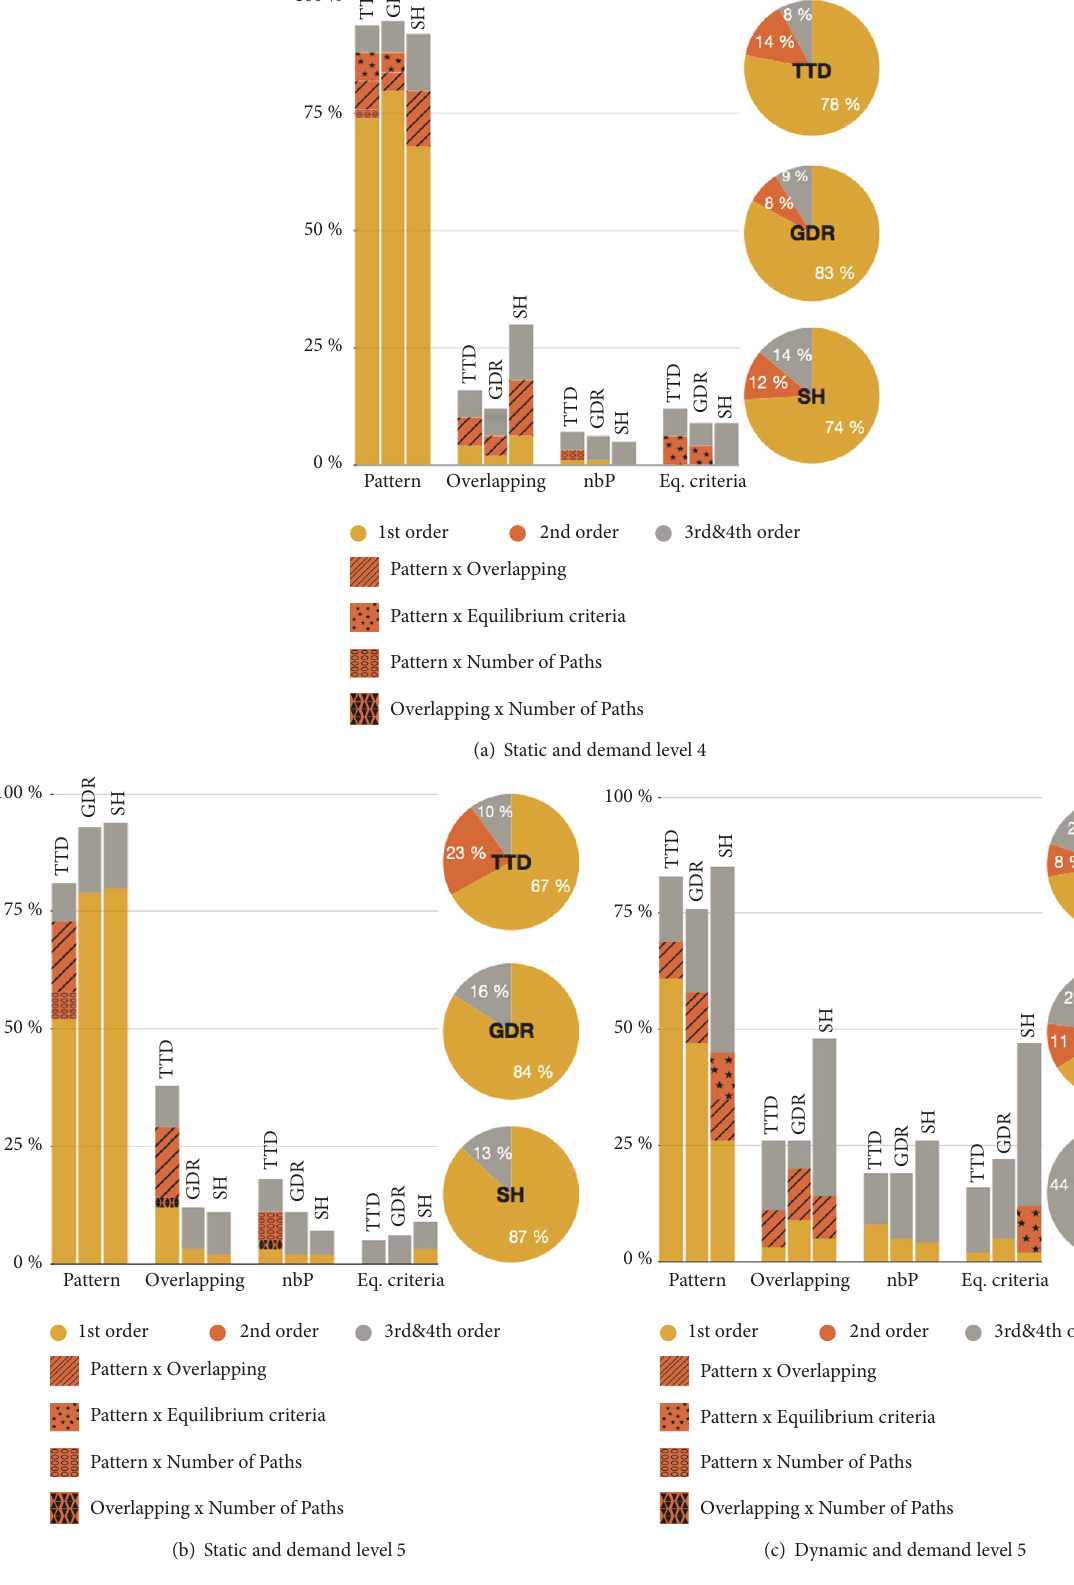
Figure 16: Presentation of Sobol indices for three representative case